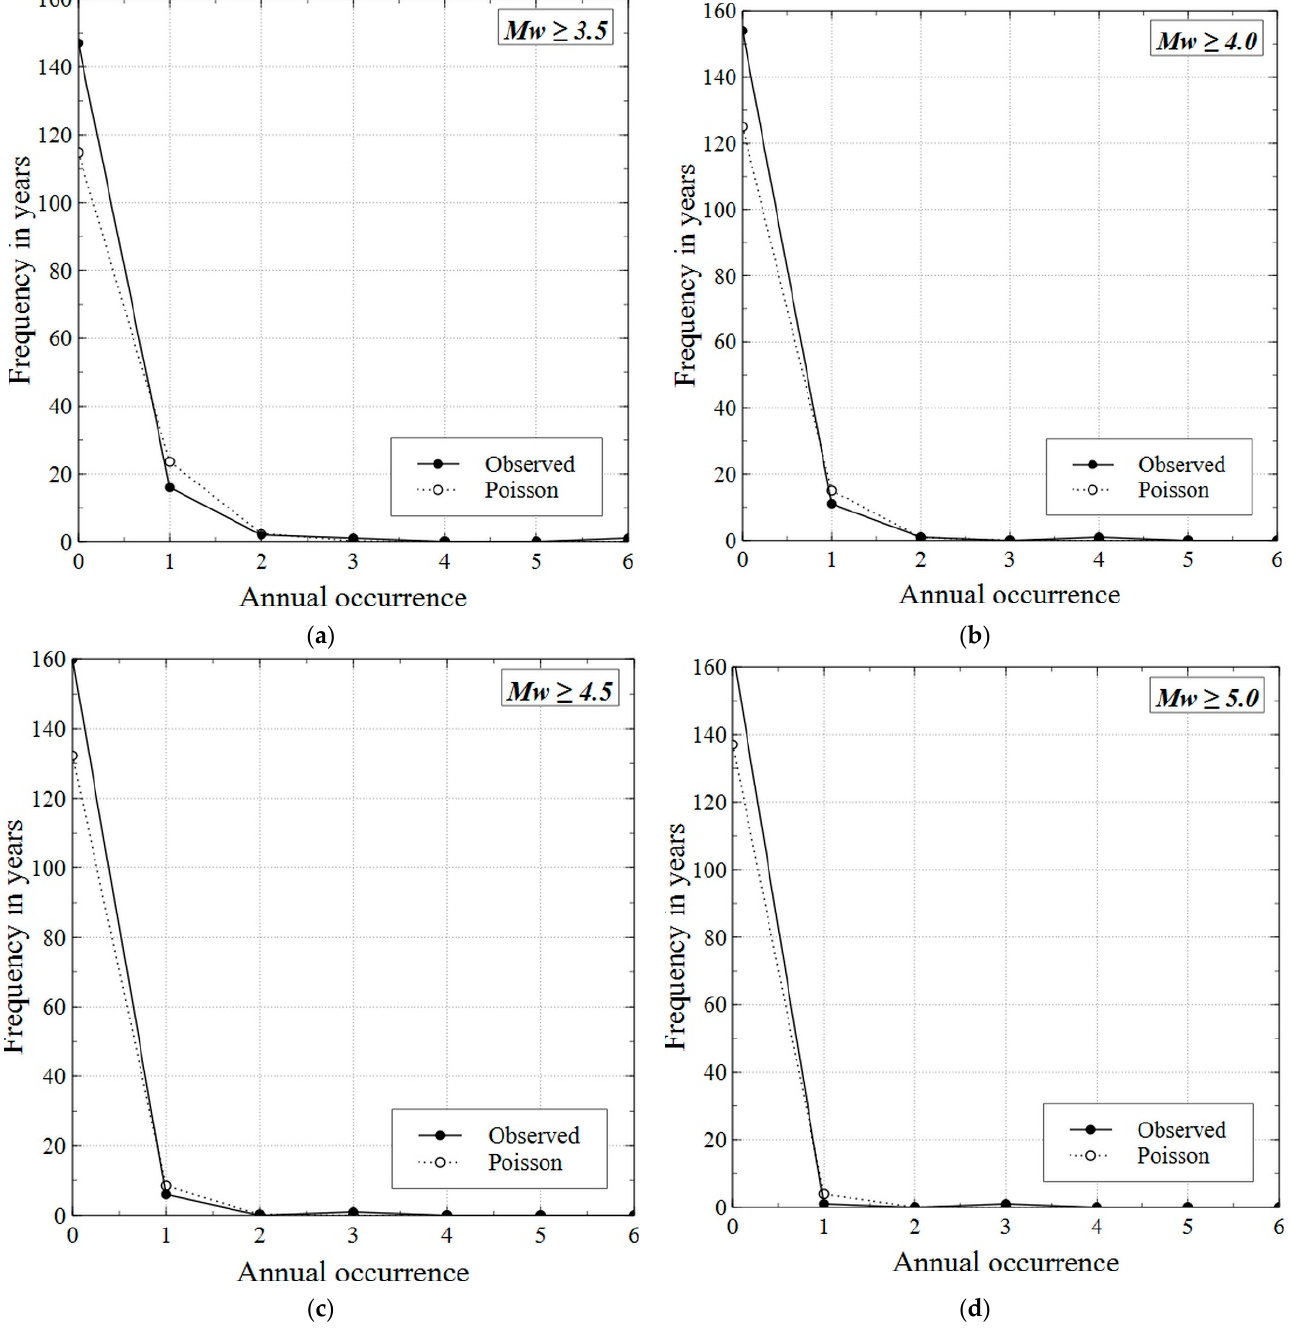
Figure 3. Comparison between the observed and the theoretical earthquake frequency occurrence for earthquakes occurring in the Fagaras ‐ Campulung seismic source with: ( a ) M W ≥ 3.5; ( b ) M W ≥ 4.0; ( c ) M W ≥ 4.5; ( d ) M W ≥ 5.0.